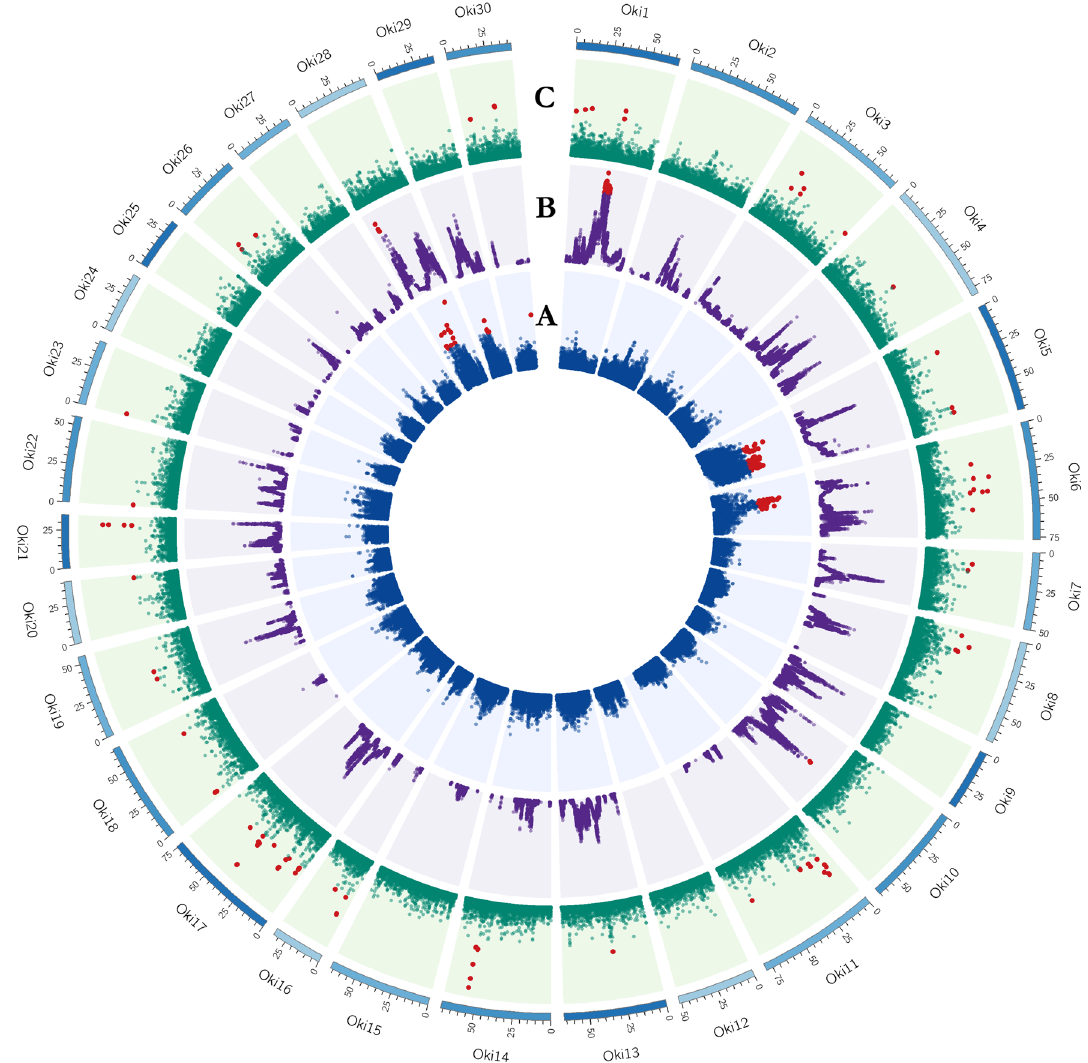
Figure 4. Circos plot of the global distribution of selection signatures across the genome in Pop-A. The circles from inside to outside illustrate: ( A ) -log 10 (p-value) of iHS (Blue); ( B ) −log 10 ( p value) of XP-EHH (Purple) and ( C ) CLR values (Green). Values for each test surpassing the threshold (iHS and XP-EHH ≥ 3, and CLR ≥ 4.81) are highlighted in